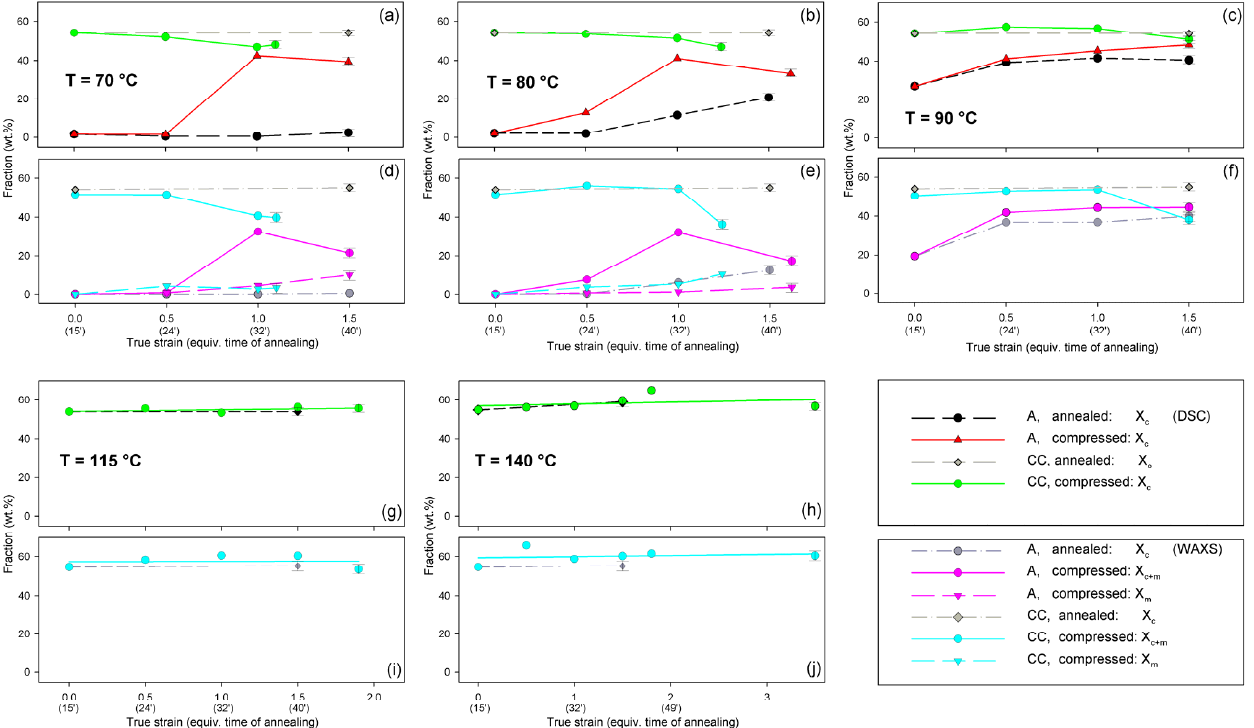
Figure 13. Phase composition (fraction of the crystalline phase and the mesophase) in A and CC samples deformed by plane-strain compression and the reference samples subjected to annealing at the respective temperature and time equivalent to the time of deformation. ( a – c , g , h ): composition determined from DSC; ( d – f , i , j ): composition estimated from X-ray diffractograms through peak fitting procedure. The temperature of deformation or annealing: 70 °C—( a , d ); 80 °C—( b , e ); 90 °C—( c , f ); 115 °C—( g , i ); and 140 °C—( h , j ).